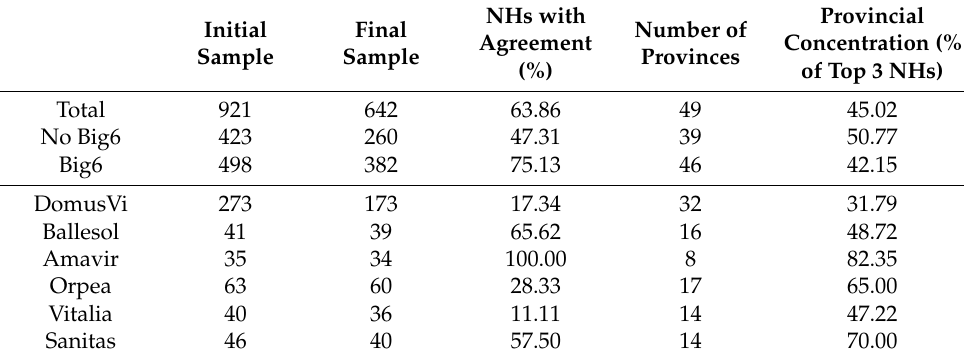
Table 1. Distribution of the sample of private NHs affiliated to a